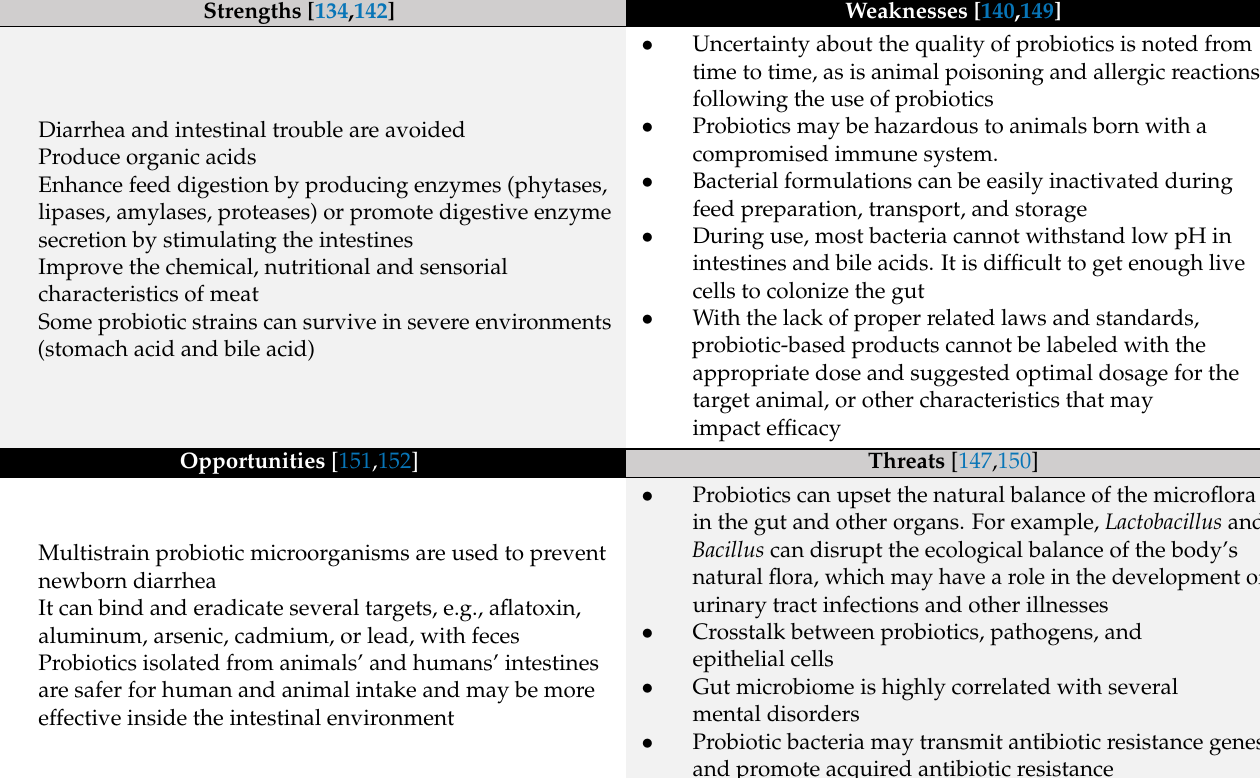
Table 5. SWOT analysis of probiotics and direct-fed